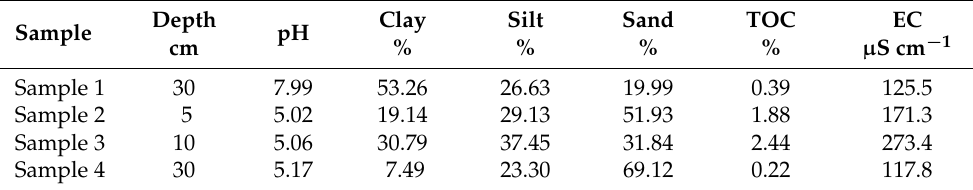
Table 1. Summary statistics of the laboratory analysis for soil samples.